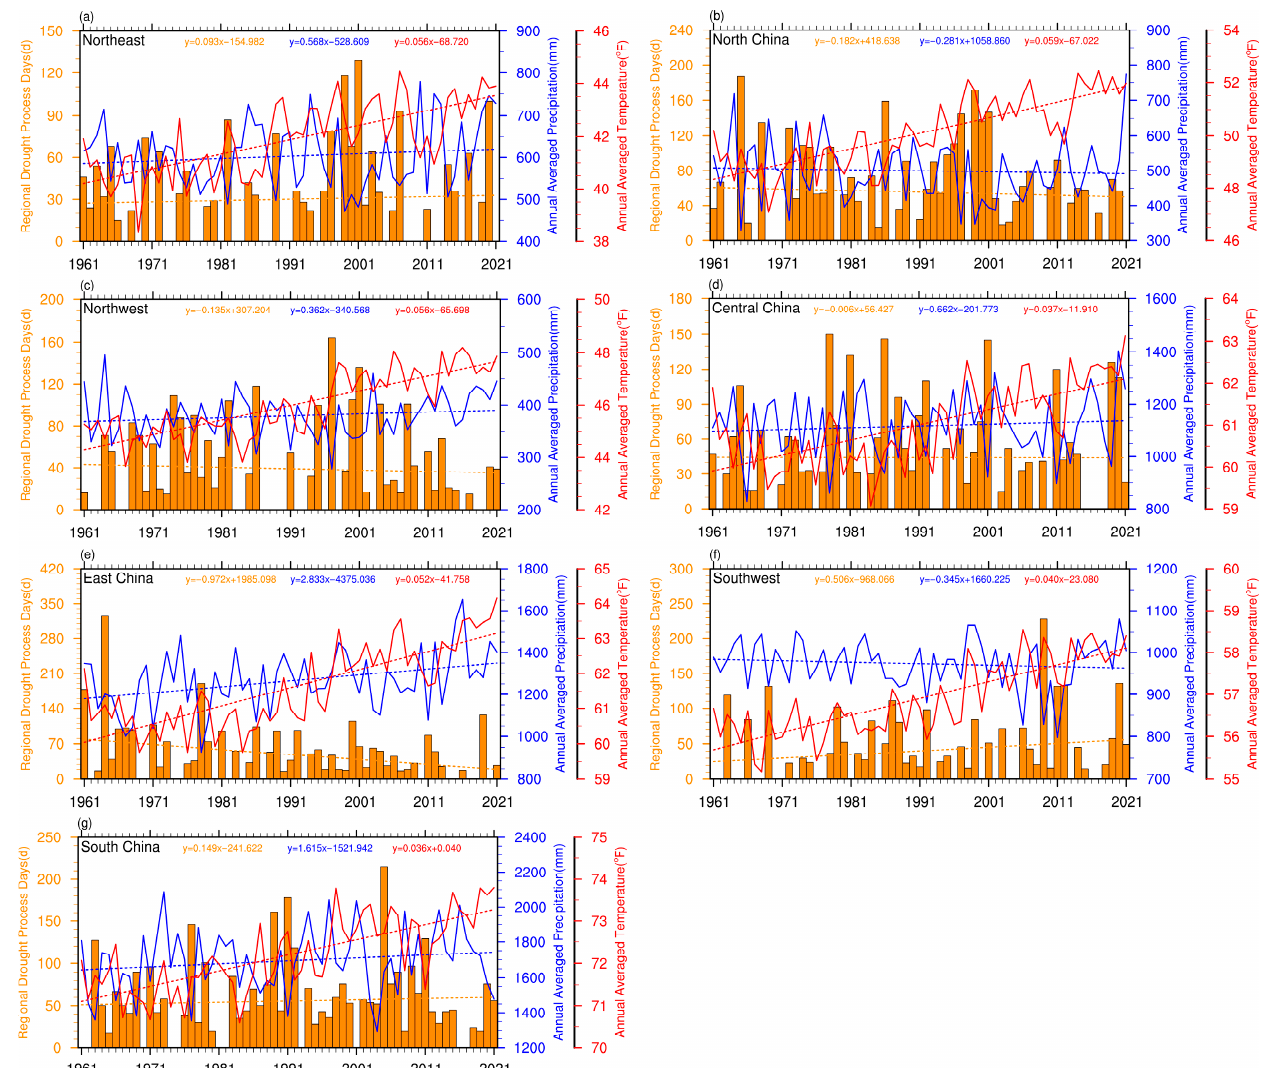
Figure 9. ( a – g ) Annual average precipitation and aunnal averge temperature combined with drought days in the seven region of China from 1961 to